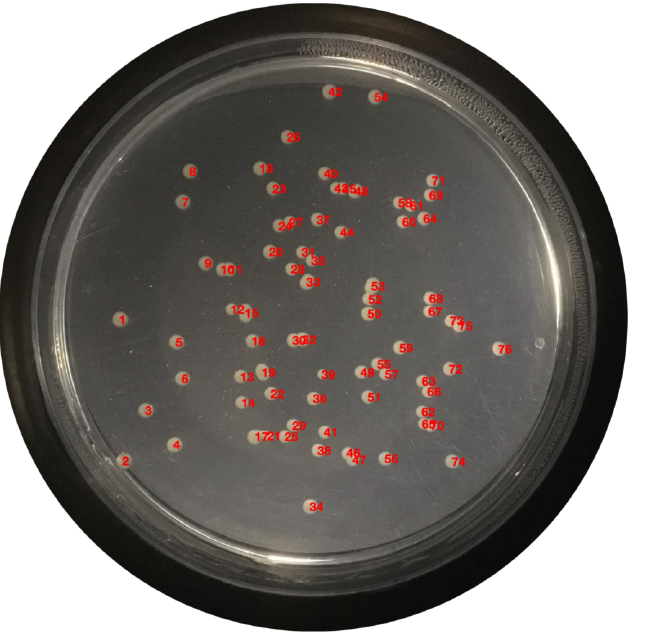
Figure 19. Enumerated colonies on the original